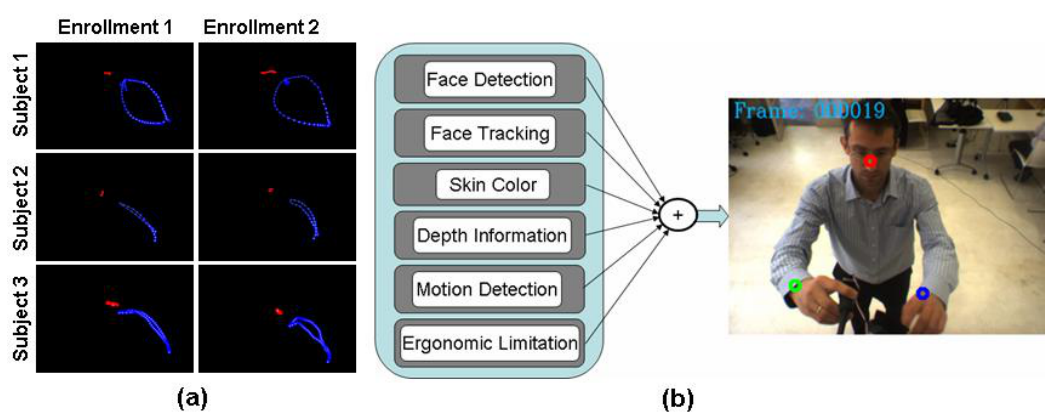
FIGURE 9 . (a) Extracted trajectories from user’s movements, (b) tracking of the user’s